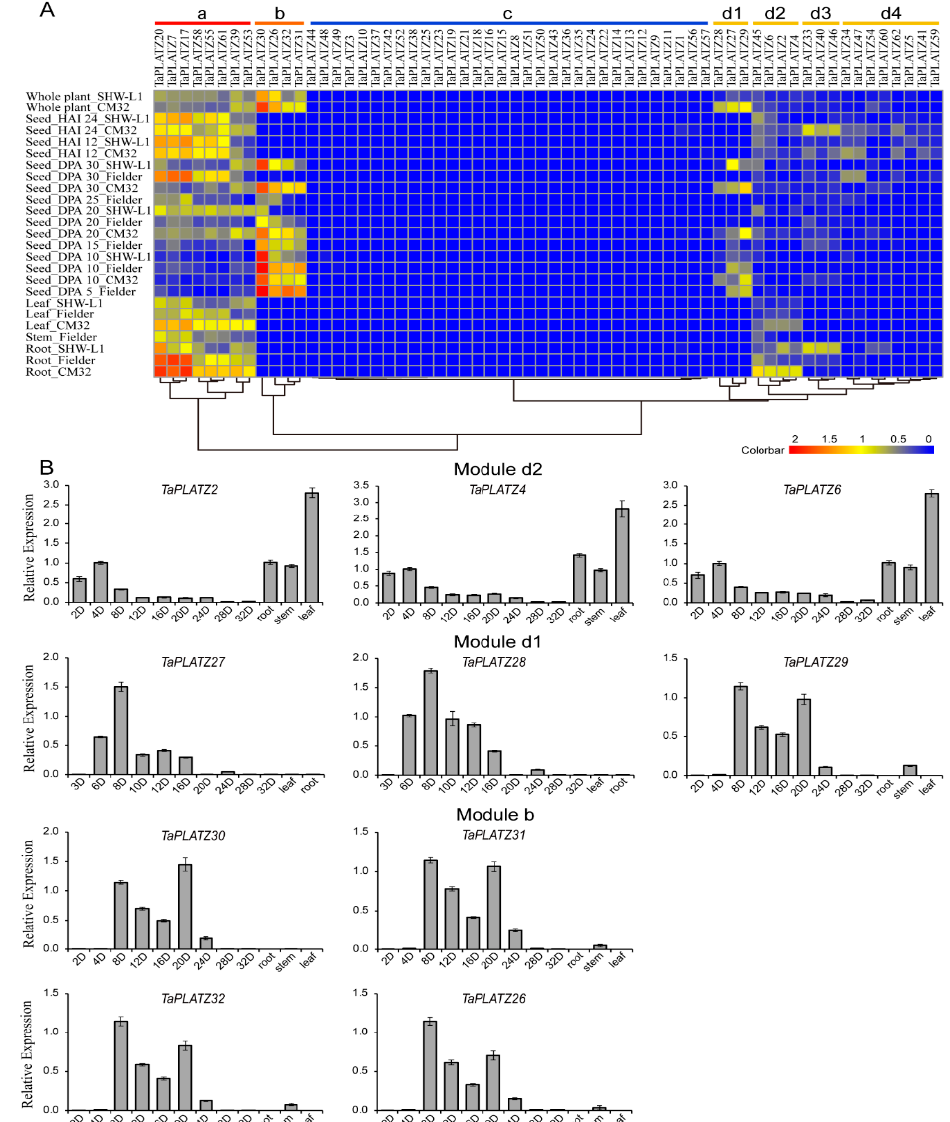
Figure 5. The expression profiles of TaPLATZ s in wheat. ( A ) Heat map of TaPLATZ genes expression in different tissues and developmental stages. Colorbar represents the expression abundance of RNA-seq data. CM32: Chuanmai 32; HAI 12: seeds after 12 h of imbibition; HAI 24: seeds after 24 h of imbibition; DPA: days post-anthesis. ( B ) Real-time PCR data of ten selected TaPLATZs from Modules b, d1, and d2 in different developmental stages of seeds, root, stem, and leaves.